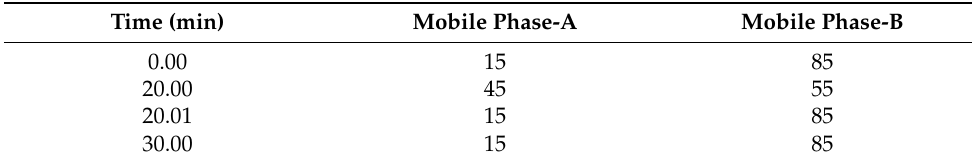
Table 1. Gradient elution